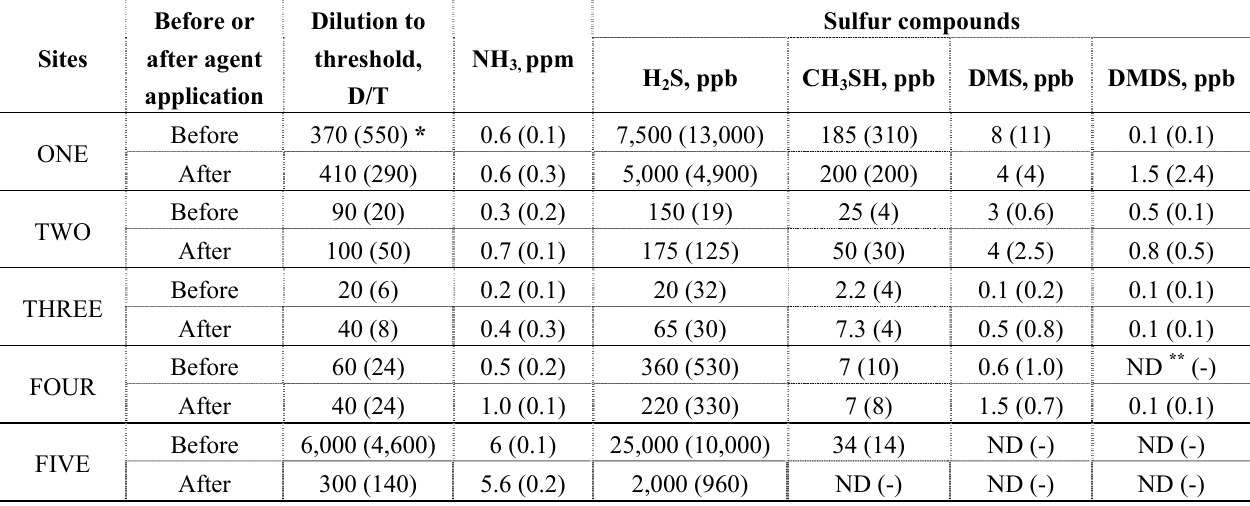
Table 2. Results of odor and odorants measurement at Districts A, B, C, D and